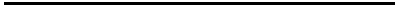
Fig. 9. The relationship between the wavelength error caused by the VHG mechanical rotation part and the particular ro- tational position. Table 1. Di®raction e±ciency of the volume holographic grating at 488, 532 and 633